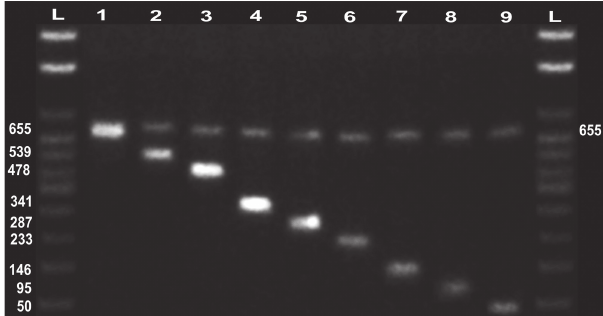
Fig. 2. Results of the electrophoresis of the universal COI fragment (655 bp) of grouper species of the family Epinephelidae. 1. Epinephelus quinquefasciatus , 2. E. morio , 3. E. itajara , 4. Hyporthodus flavolimbatus , 5. Mycteroperca microlepis , 6. M. bonaci , 7. M. marginata , 8. H. niveatus and 9. M. acutirostris . L. Molecular